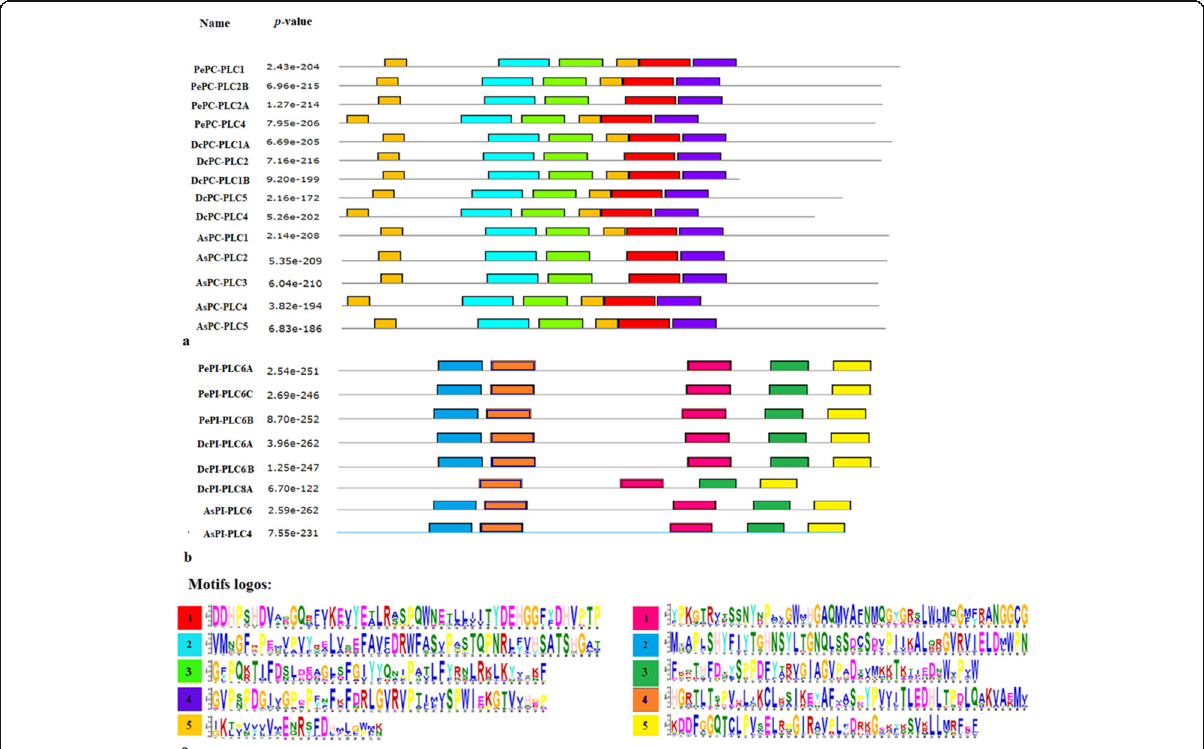
Fig. 3 Motif analyses in PePLC, DcPLC, and AsPLC. Motifs were predicted by the MEME suite online server. a Conserved motifs in PePC-PLC, DcPC-PLC, and AsPC-PLC sequences, marked in colored boxes. b Conserved motifs in PePI-PLC, DcPI-PLC, and AsPI-PLC sequences, marked in colored boxes. c Sequence logo of PI-PLC and PC-PLC protein motifs obtained by the MEME